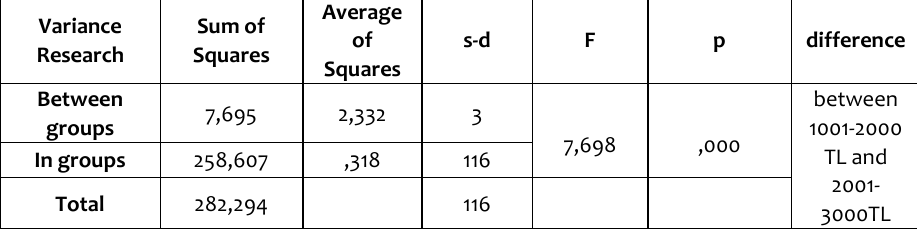
Table 5. Results Of One-Factor Variance Analysis For The Differences In The Views Of Obese Individuals Participating İnto The Research Towards Socialization, Based On Their